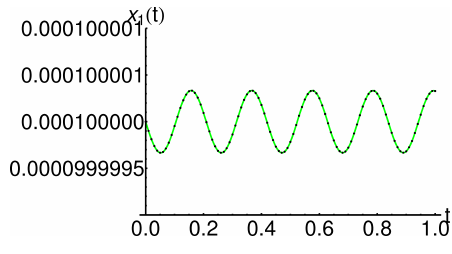
Fig. 1. Comparison between the approximate solutions ¯ x 1 given by Eq. (28) and the corresponding numerical